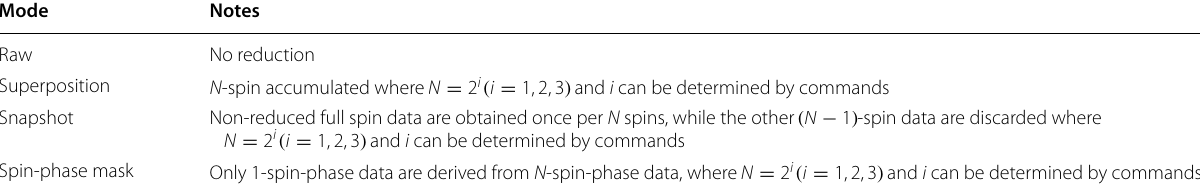
Table 3 Data reduction modes of the MEP-i